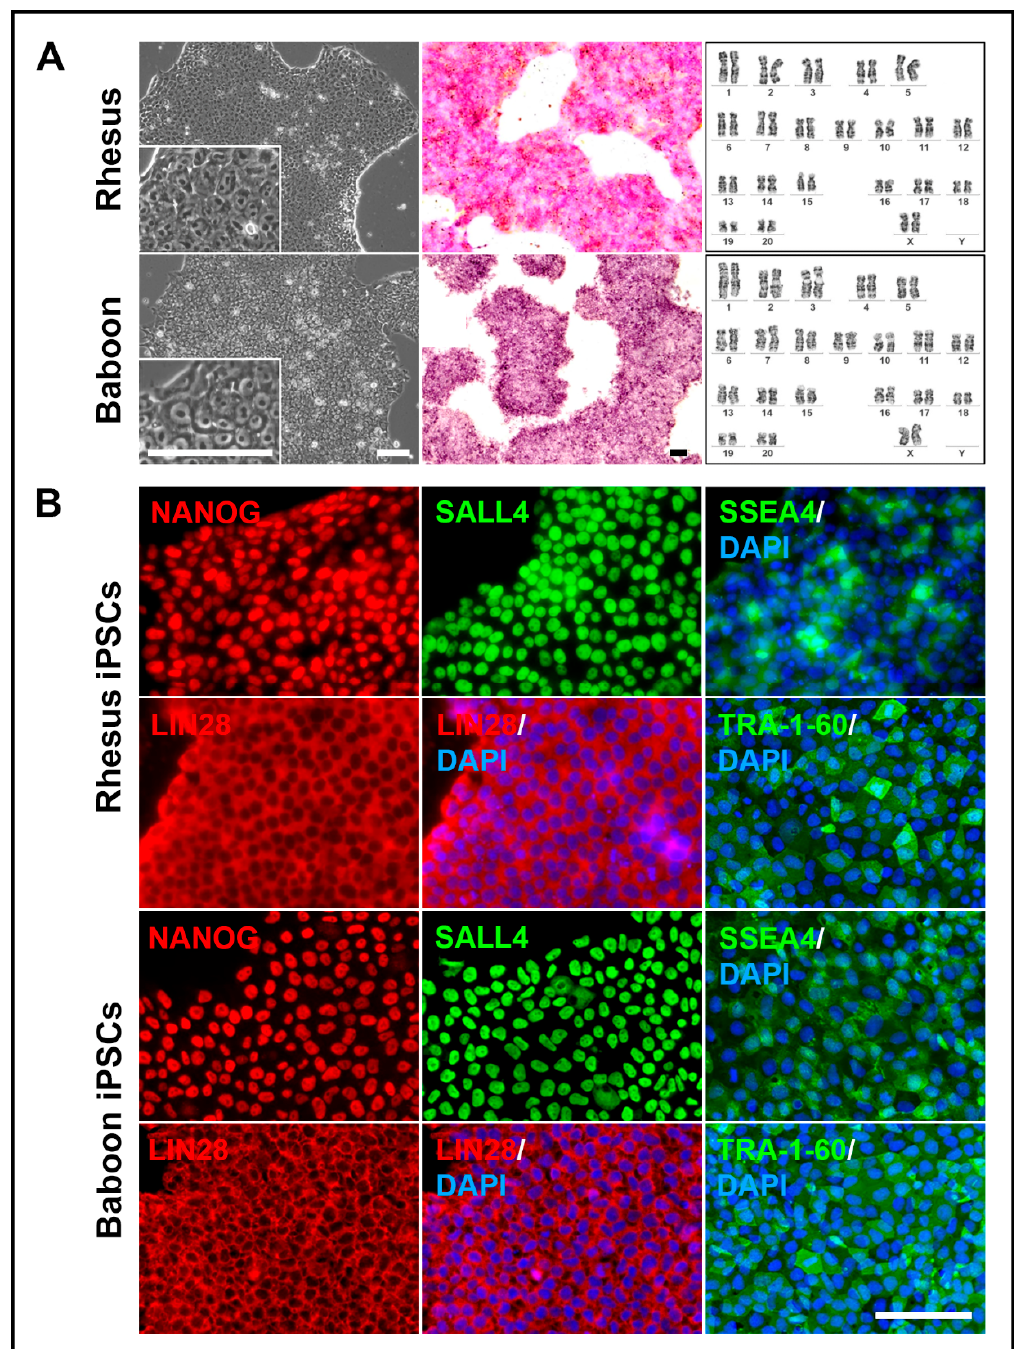
Figure 5. Characterization of transgene-free NHP-iPSCs. ( A ) Rhesus and baboon iPSCs cultured under feeder-free conditions (left) demonstrate alkaline phosphatase activity (middle) and show a normal karyotype (right). ( B ) Rhesus (upper panel) and baboon (lower panel) iPSCs express pluripotency related transcription factors NANOG and SALL4, pluripotency related surface markers SSEA4 and TRA-1-60 as well as LIN28. Scale bars: 100 μ m.